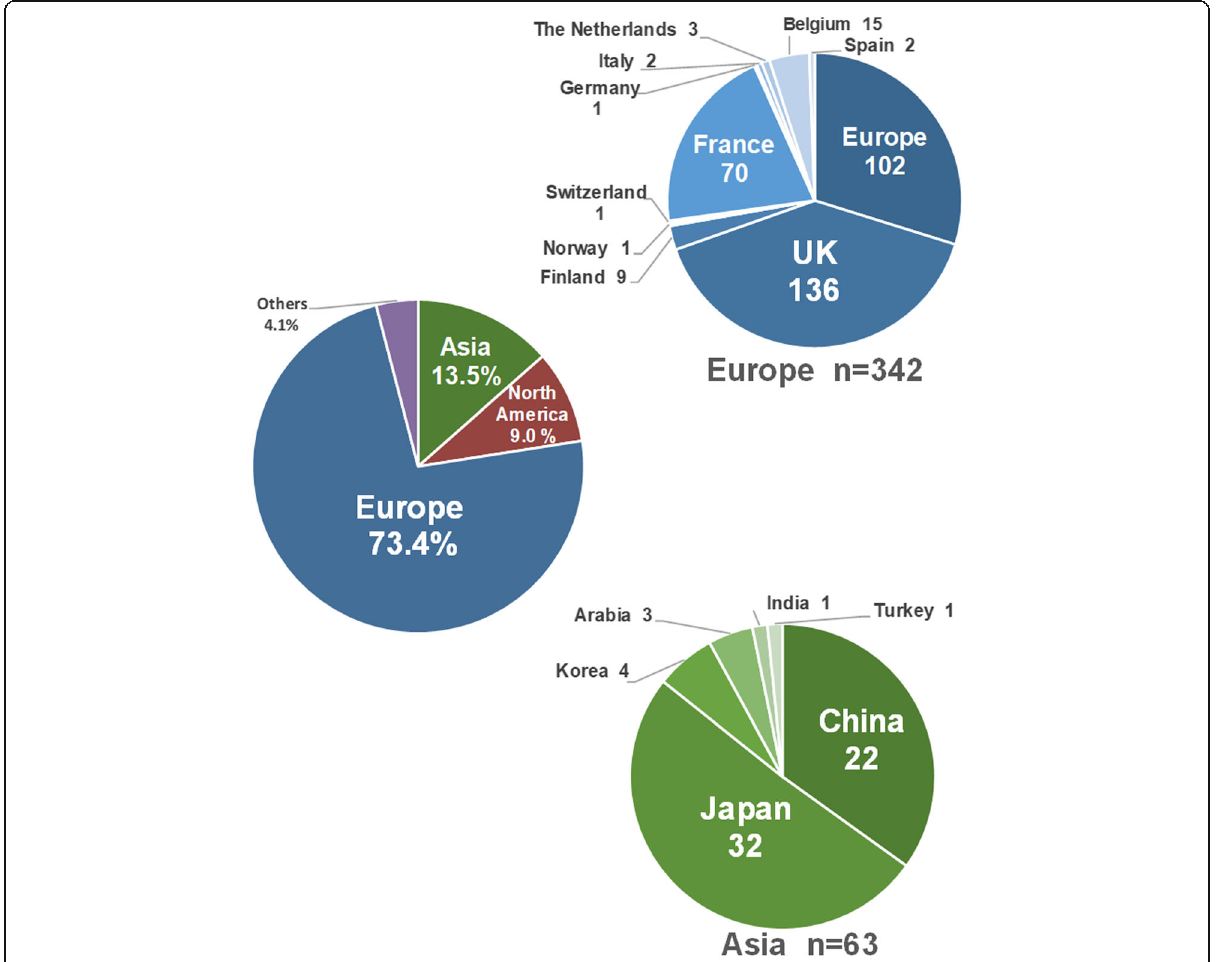
Fig. 1 Population distribution of STL1-related COL2A1 mutation reports. The pie-chart shows the number and percentage of STL1 patients harboring COL2A1 variants from different